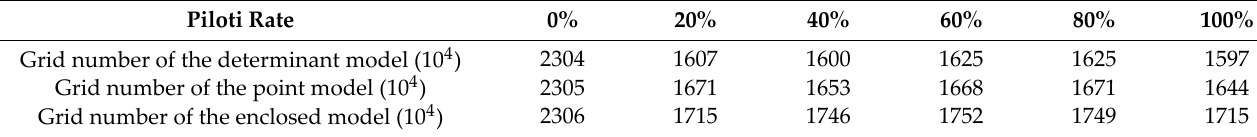
Figure 6. Schematic diagram of the x-z section grid. Table 3. Grid information.